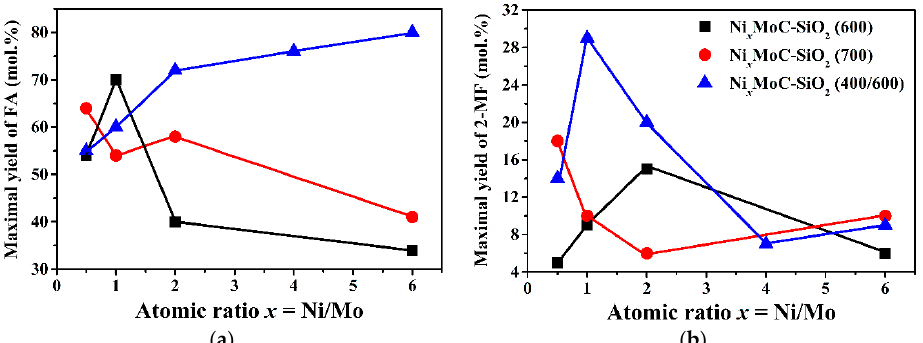
Figure 2. A comparison of FA ( a ) and 2-MF ( b ) yields for the catalysts obtained under different temperature treatment regimes. Conditions of furfural hydrogenation: T = 150 °C, P = 6.0 MPa, m cat = 1.000 g, and furfural/isopropanol molar ratio equal to 0.033.